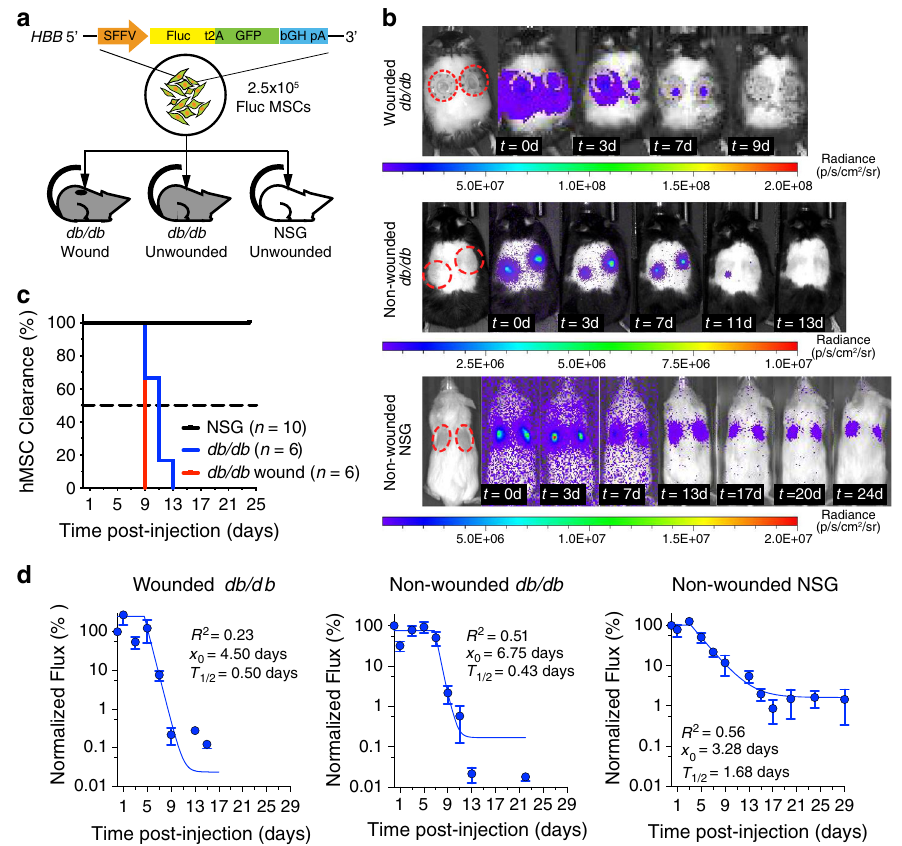
Fig. 3 Both immunogenicity and poor survival contribute to clearing of subcutaneously injected hBM-MSCs in mouse xenotransplantation models. a Cas9-AAV6-engineered bi-cistronic fi re fl y luciferase + GFP + hBM-MSCs (Fluc MSCs; 2.5 × 10 5 cells/injection) were injected into 6-mm cutaneous wound beds of db / db mice on the day of wounding (wounds: n = 6), and subcutaneously in unwounded db / db mice (injections: n = 6) or in NSG mice ( n = 10). In vivo luciferase activities were measured over the course of up to 24 days with D -luciferin intraperitoneal injection and IVIS imaging systems. b Representative overlay bioluminescence and still animal images show source and intensities of emitted photons. Representative time series show decreasing luciferase activities of Fluc MSCs in injected mice overtime. c Kaplan – Meier ’ s plot shows time to complete clearance of luciferase activities from individual injection sites in each subject groups. d Dots and trendlines represent average net fl ux measured from each injection sites over time normalized to those measured on the day of Fluc MSC injection. Net fl ux values above baseline are shown. Dots and error bars represent mean value and standard deviation. Trendlines represent best plateau and one-phase decay curve fi t of normalized fl ux. R2, x 0 , and T 1/2 represent goodness of fi t, plateau duration, and half-life, respectively. Complete clearance is determined by baseline photon fl ux measured from un-injected control animals. Luminescence fl ux from wounds or skin injected with Fluc MSCs was measured over time. Source data are available in the Source data fi